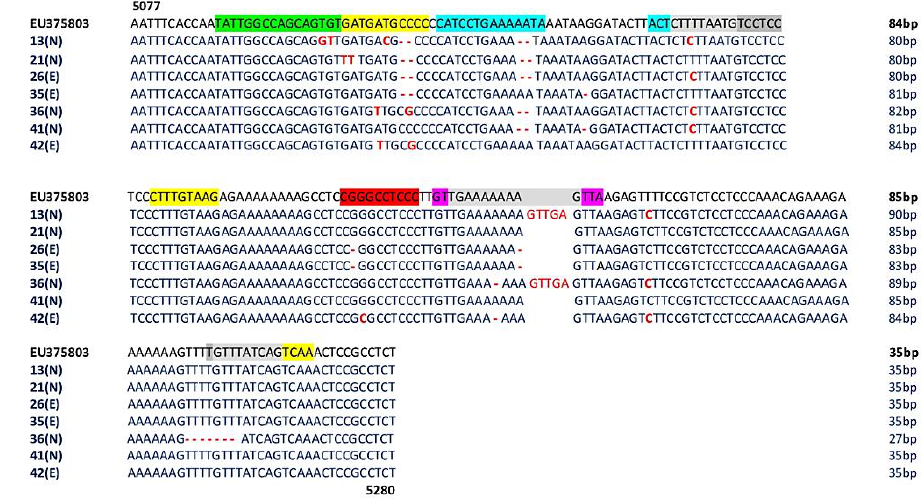
Figure 1. Schematic representation of the MCPyV genome (strain MCC350). The double-stranded DNA genome is 5387 bp in length. The early region encodes the large T antigen (LT), small T antigen (sT), 57 kT antigen (57 kT) and ALTO (alternate frame of the large T open reading frame). These genes function to allow for viral DNA replication. The late region is transcribed in the opposite direction and encodes the structural components of the virus capsid: virus protein 1 (VP1) and the minor capsid proteins virus protein 2 (VP2). MCPyV does not seem to express virus protein 3 (VP3), and virions do not seem to contain VP3, despite an in-frame internal ATG start codon in the VP2 gene. At the top of the figure, the amplified noncoding control region (NCCR) of 203 base pair (bp) (5077 – 5280 bp). Putative binding sites for cellular transcription factors are highlighted in different colors as follows: